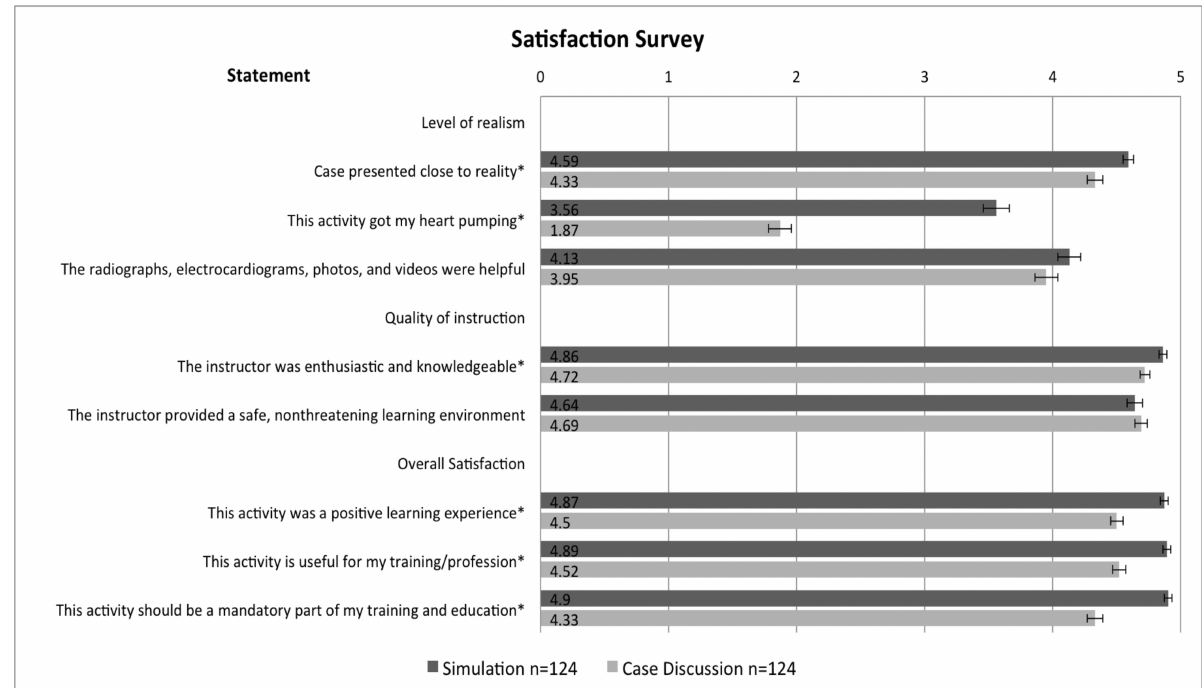
Figure 3 - Satisfaction survey for each teaching method ( * p o